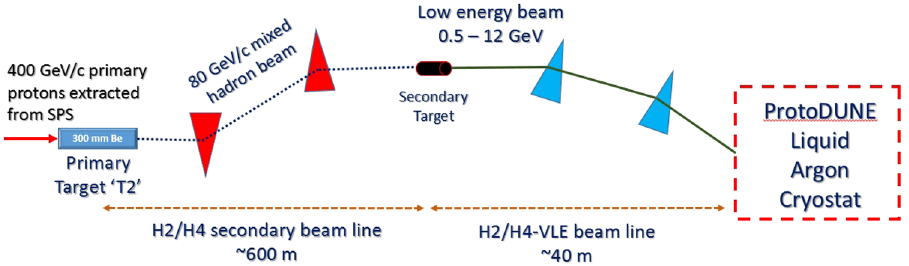
FIG. 3. Conceptual layout of the H2/H4 beam line and the newly designed VLE part, leading to the 11 × 11 m NP-02/04